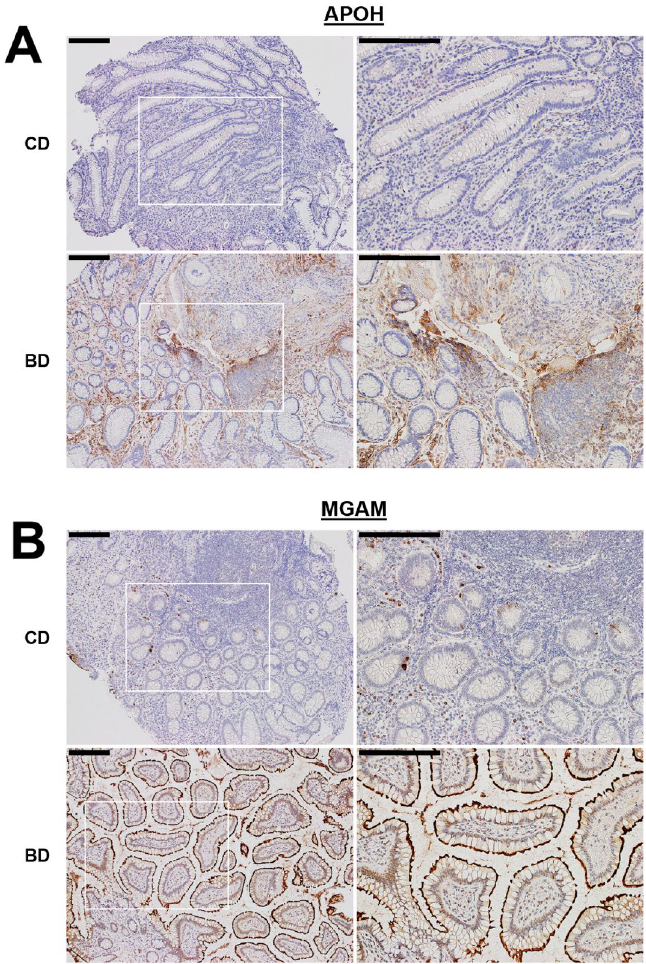
Figure 3. APOH and MGAM expression in the colonic mucosa. Tissue sections from patients with CD or BD stained with antibodies against APOH ( A ) or MGAM ( B ). The selected areas denoted by white boxes in left panels (original magnification, 100 ×) are enlarged in the right panels (200 ×). Scale bar, 200 µm.